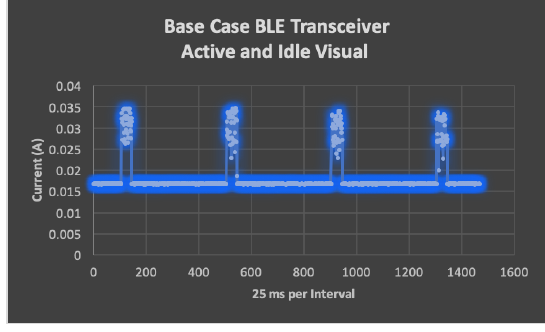
Figure 6. Active and idle